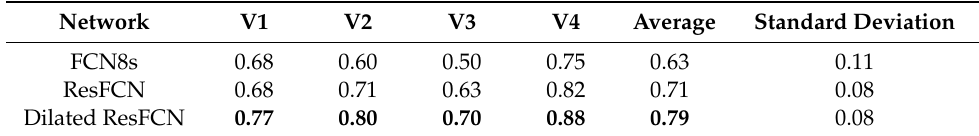
Table 1. The Dice coe ffi cient results obtained on V1–V4 validation folds for the FCN8s, ResFCN, and Dilated ResFCN. The Dice coe ffi cient and standard deviation, averaged over all validation sets, are also